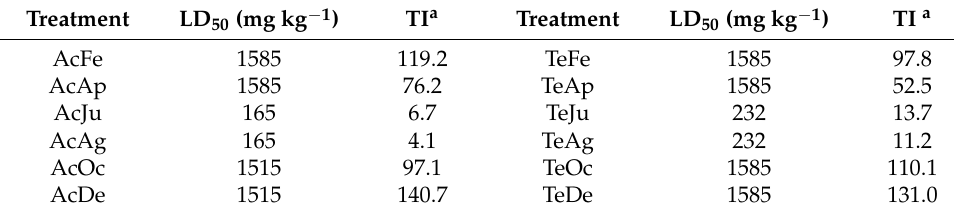
Table 5. Acute oral toxicity and therapeutic index of the extracts from A. muricata leaves.